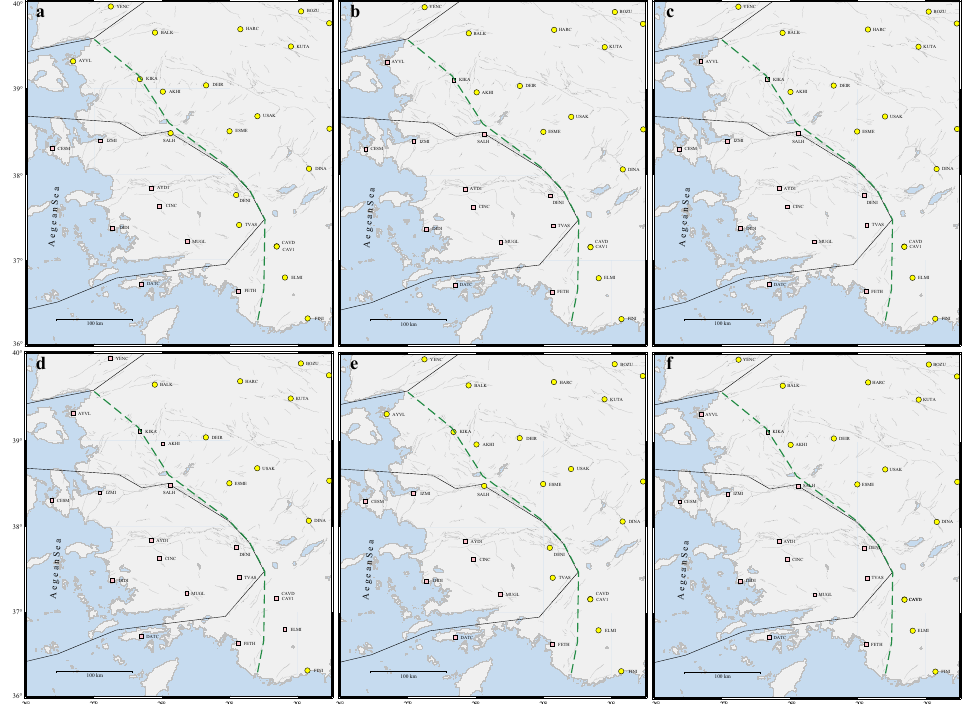
Figure 9. Comparison of individual clustering results with ensemble clustering for western Turkey with: ( a ) BIRCH; ( b ) HAC; ( c ) k -means; ( d ) mini batch k -means; ( e ) spectral clustering; ( f ) MCLA results. Black solid lines are the block model at [5]. The green dashed line is our block border according to the ensemble clustering result. Gray thin lines show active faults